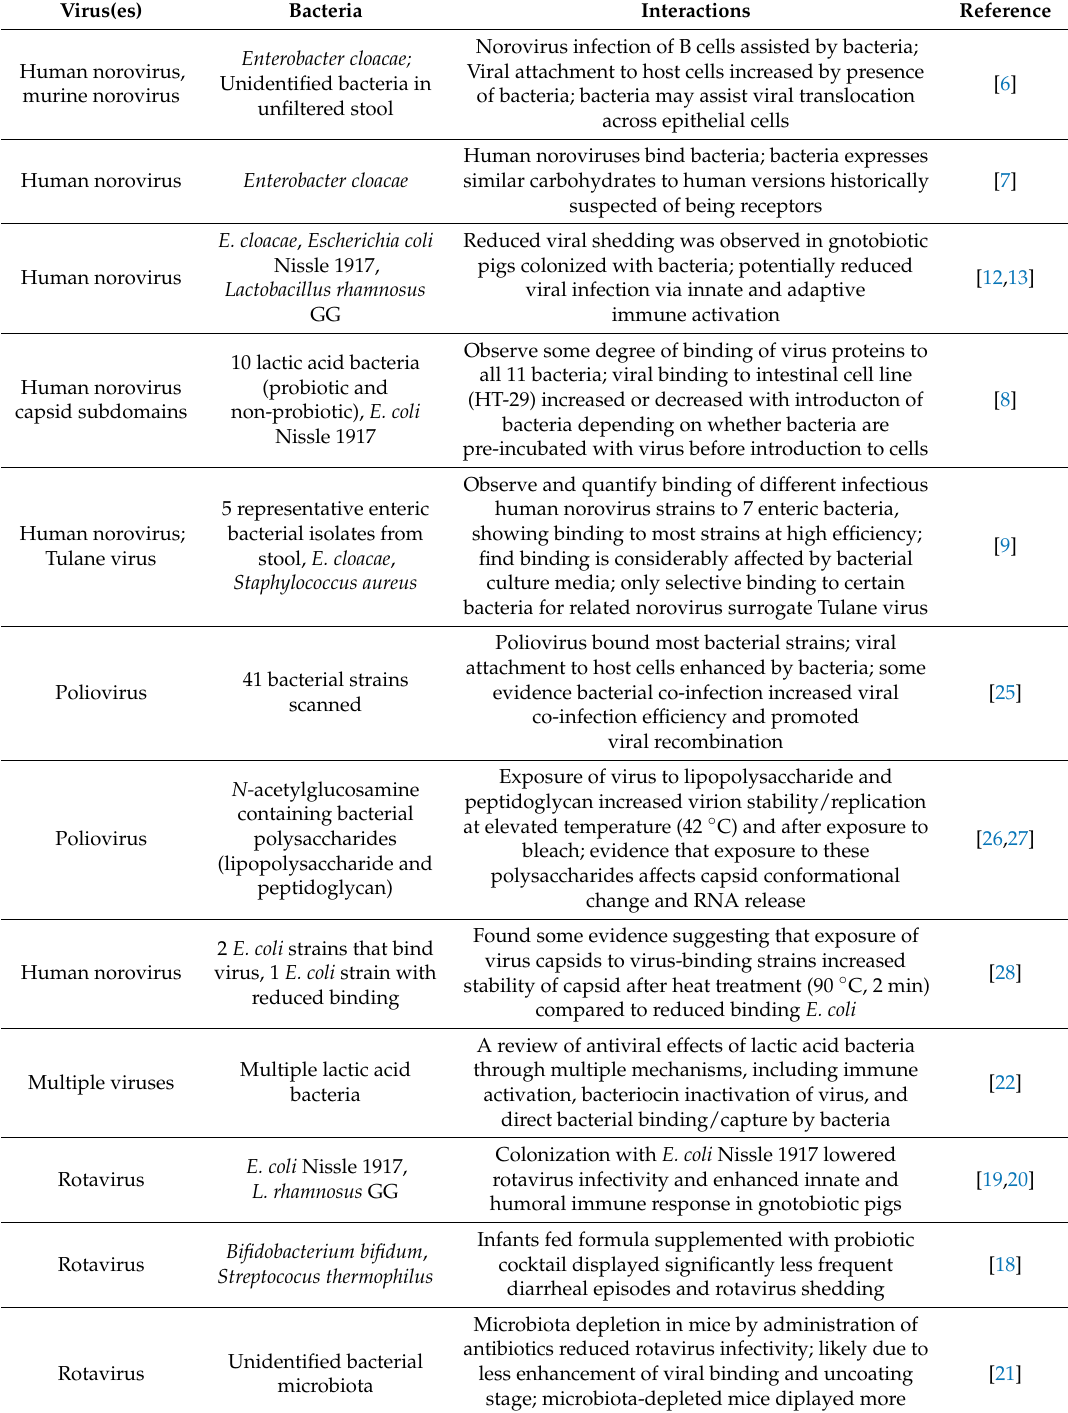
Table 1. Selected reports on eukaryotic virus–bacteria interactions in food and water